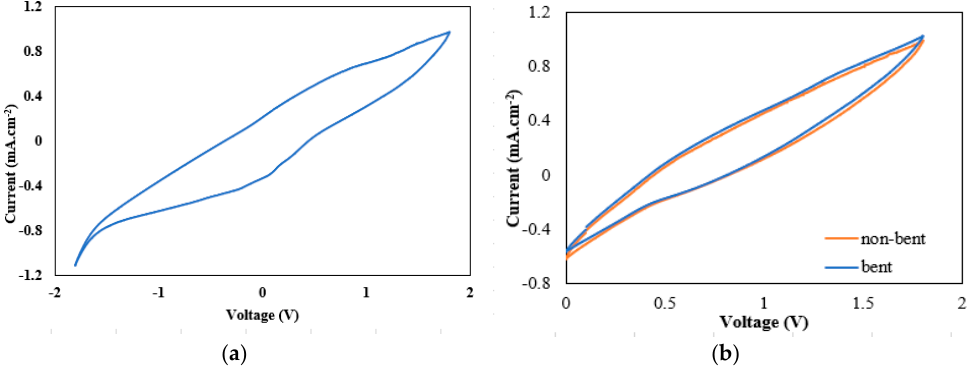
Figure 4. ( a ) CV test between − 1.8 and 1.8 V at the scan rate of 100 mV·s − 1 , ( b ) CV tests between 0 and 1.8 V at the scan rate of 100 mV·s − 1 for bent and non-bent devices at the scan rate of 100 mV·s − 1